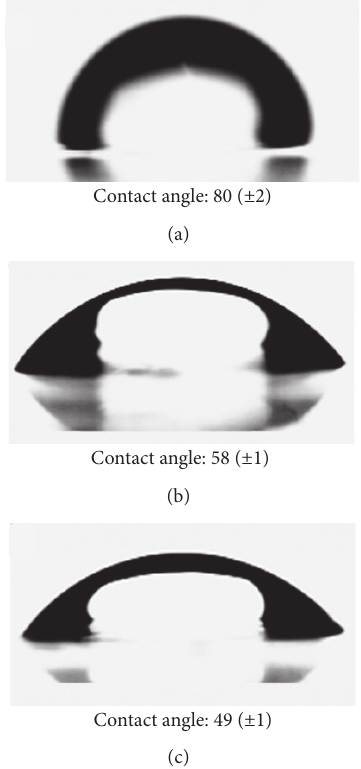
Figure 5: Images and contact angles of water droplets on the porous PU film (a), on a PU film coated with 0.1% P(MMA-co-MAA) solution (b), and on a PU film coated with 2% P(MMA-co-MAA)